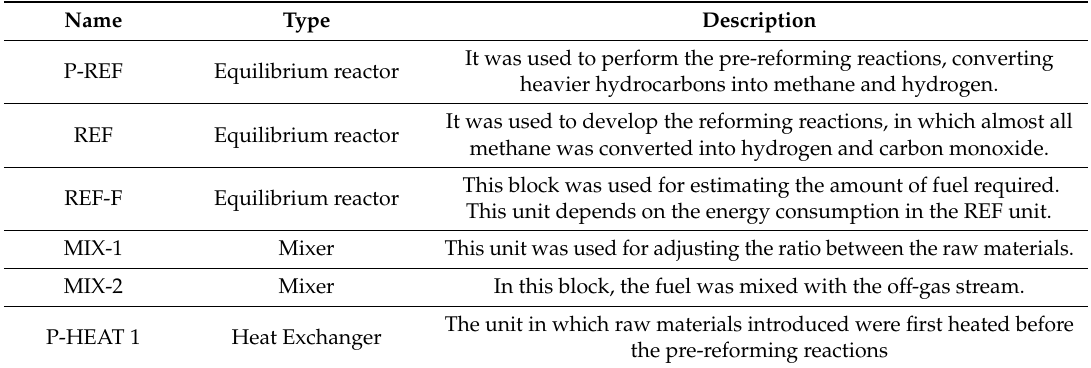
Table 2. Description of the blocks used in Section